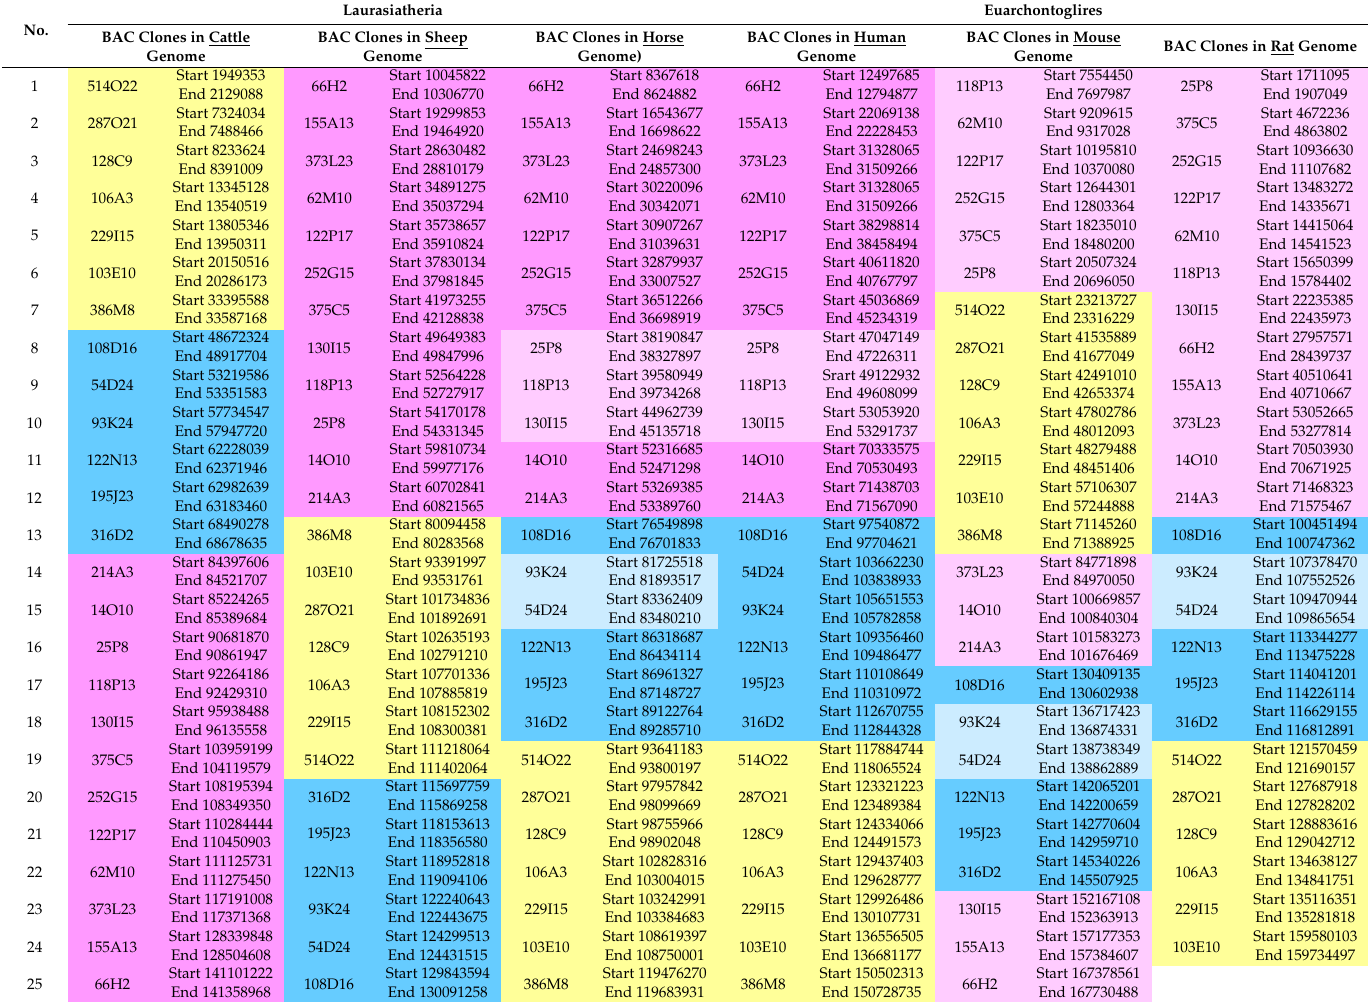
Table 3. CHORI-240 (CH-240) BAC’s order on mammalian chromosomes X. Conservative syntenic segments are colored in pink, yellow and blue. Laurasiatheria No.